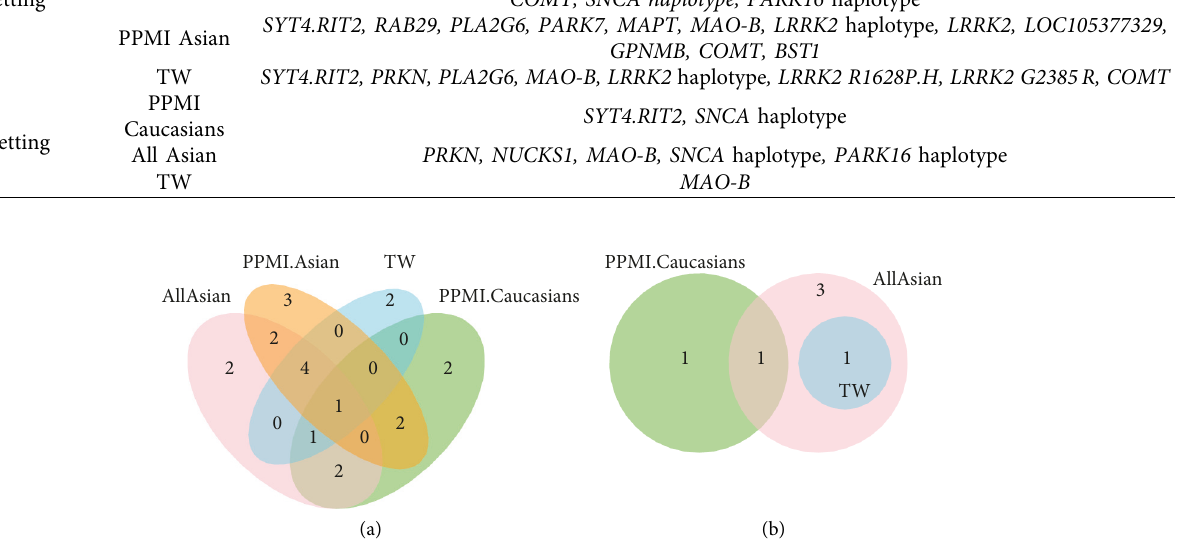
Figure 1: Venn plot of ethnicity-stratified correlation analysis. (a) Venn plot of ethnicity-stratified correlation analysis with P < 0 . 05. (b) Venn plot of ethnicity-stratified correlation analysis with P < 0 .